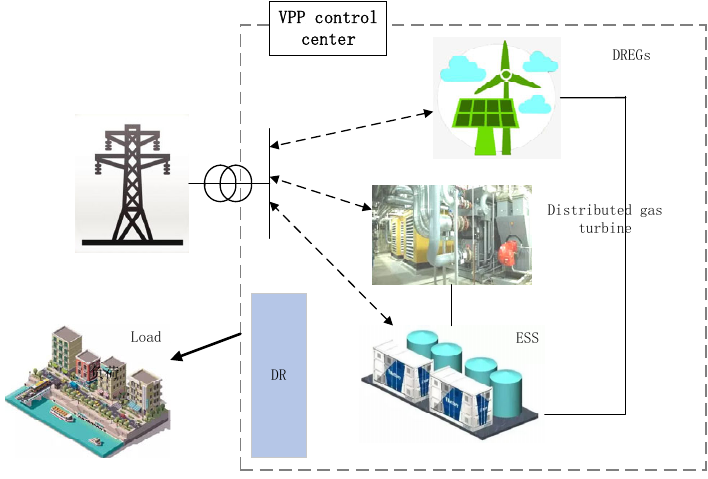
Figure 1. General structure of VPP.